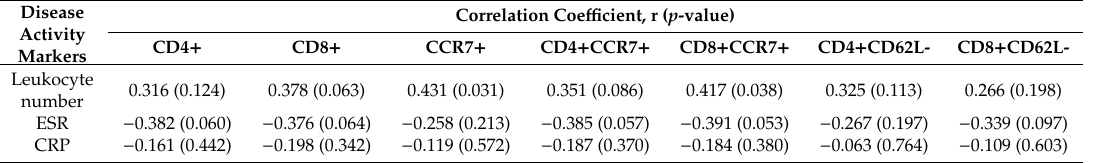
Table 4. Correlations between the frequencies of T cells and disease activity markers. Disease Activity Markers